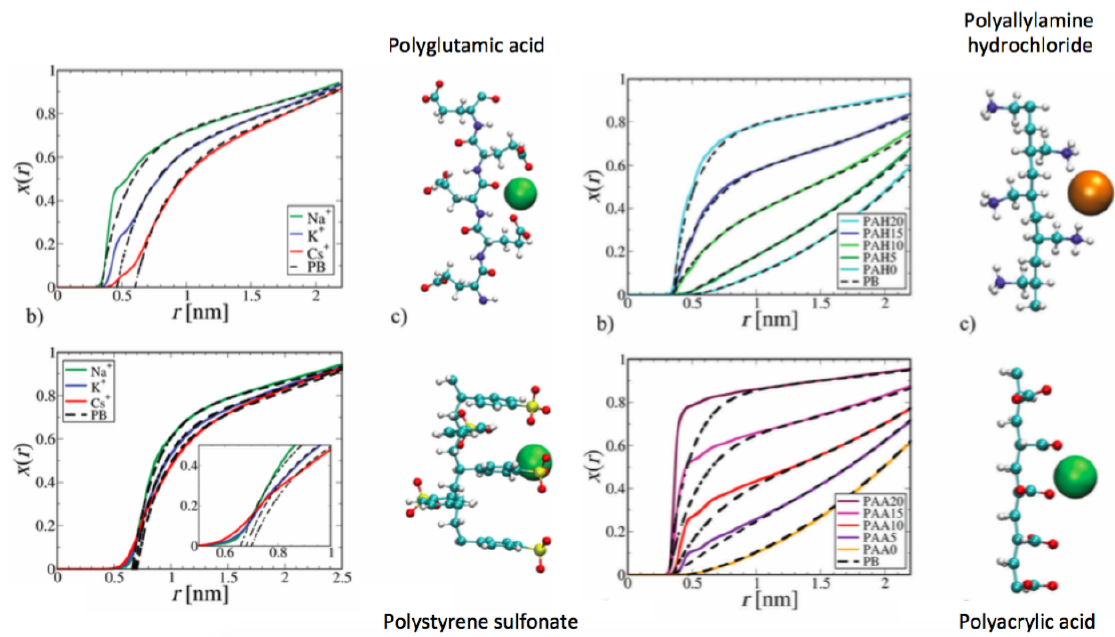
Figure 6. Fraction of condensed counterions x ( r ) around polyglutamic acid ( top left ), polyallylamine hydrochloride ( top right ), polystyrene sulfonate ( bottom left ) and polyacrylic acid ( bottom right ) for various counterion species as denoted in the legend. The dashed black lines correspond to the fits of the modified PB equation (Equation (15). The effects of varying line charge density are studied for polyacrylic acid and polyallylamine hydrochloride on the right side. Figure adapted from Ref.